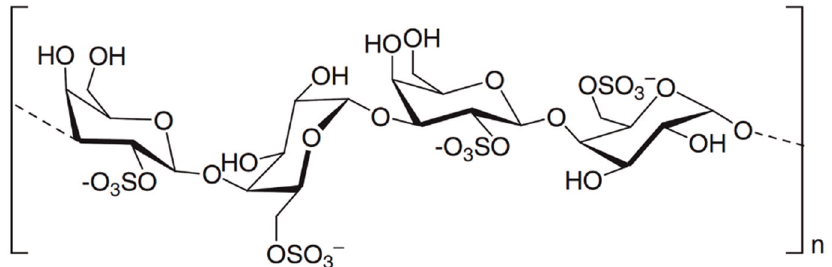
Figure 13. The D , L -galactan hybrid C2S-3 ( 69 ), isolated from the red seaweed Cryptonemia crenulata